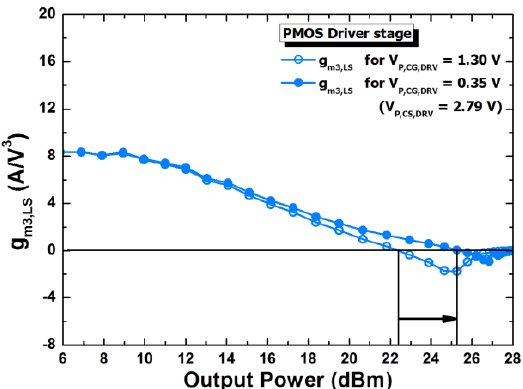
Figure 9. Simulated g m 3 ,LS according to the output power of the PMOS driver stage (V DD = 3.3 V and V P,CS,DRV = 2.79 V).